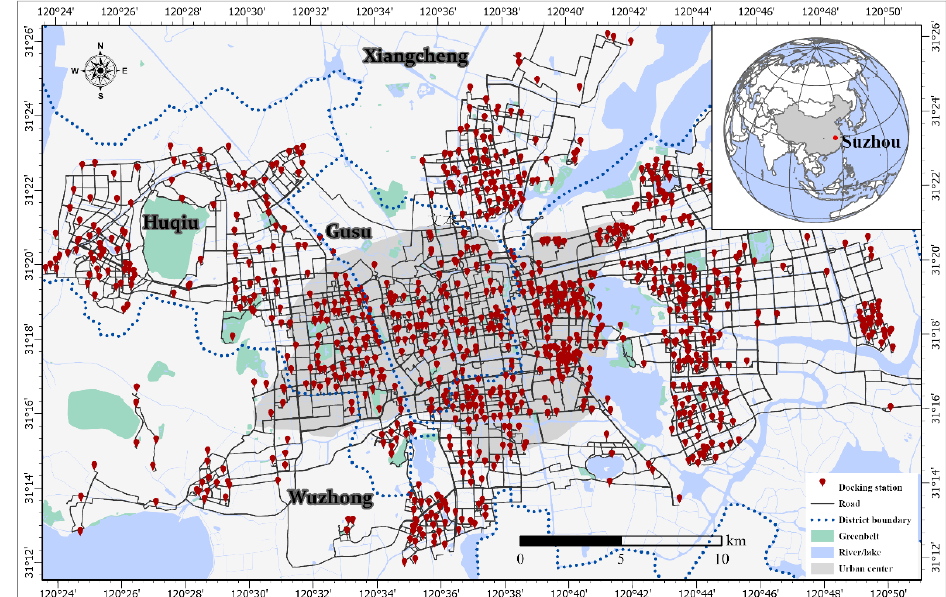
Figure 1. Study area (public bicycle system in Suzhou, China).